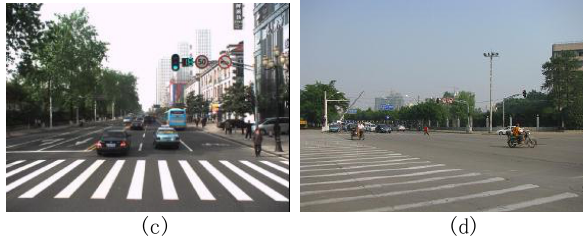
Fig 4. Digital map(a) and real images(b) of the research area The difficulty in detecting is: 1) there are many kinds of interference exist in scene, e.g. the acquired information in experimental area includes traffic signs, roads, building, vehicle, pedestrians, lines, trees, shadow etc. The spectral, shape, texture of some objects is similar with the traffic sign. 2) The same target may have different appearance under different weather and light. Fig.5. Shows saliency analysis result of different method. Compared with Itti's [18] and Hou's [19] method, the experimental result shows our method can better highlight the saliency of traffic signs and suppress irrelevant information in scene.